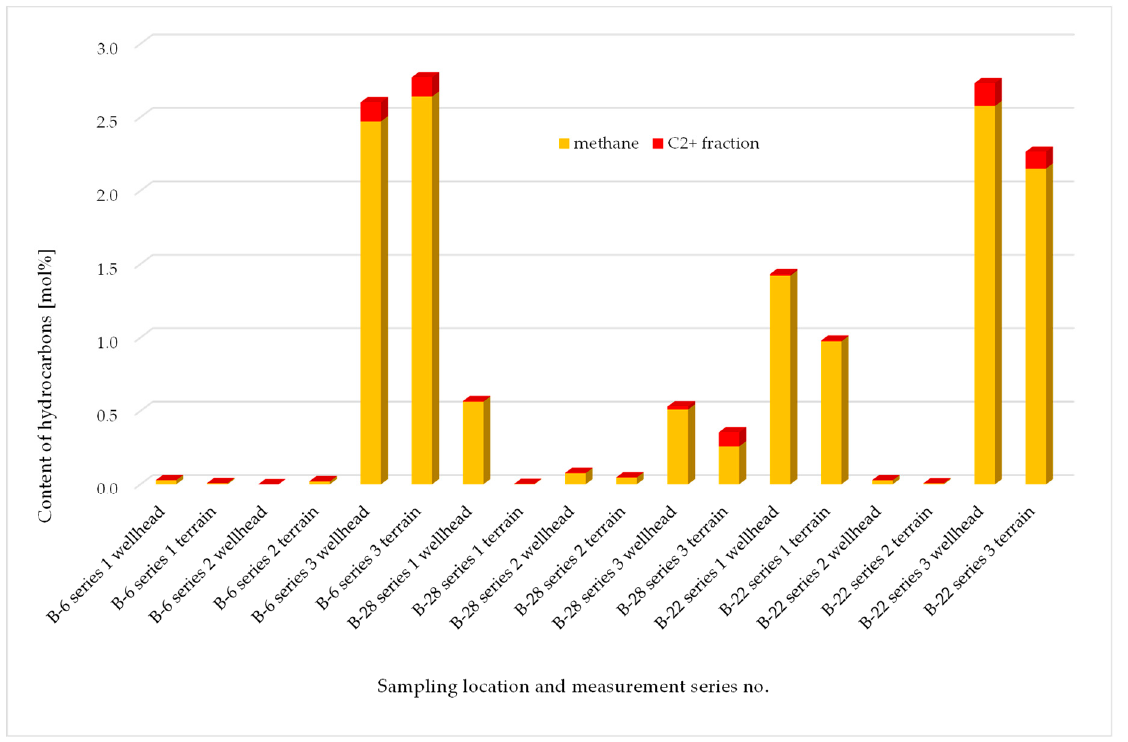
Figure 11. Hydrocarbons content in samples taken at the B-6, B-22 and B-28